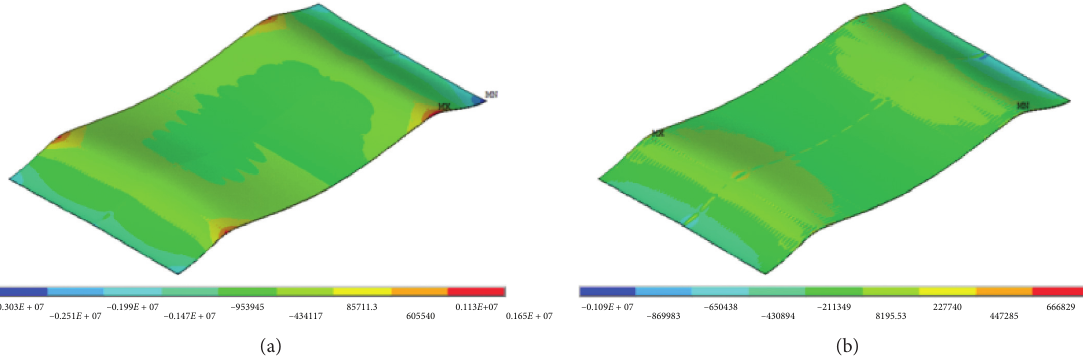
Figure 12: The stress diagram of the pavement layer under the most unfavorable bending moment of the random traffic flow. (a) The longitudinal stress diagram. (b) The transverse stress diagram.